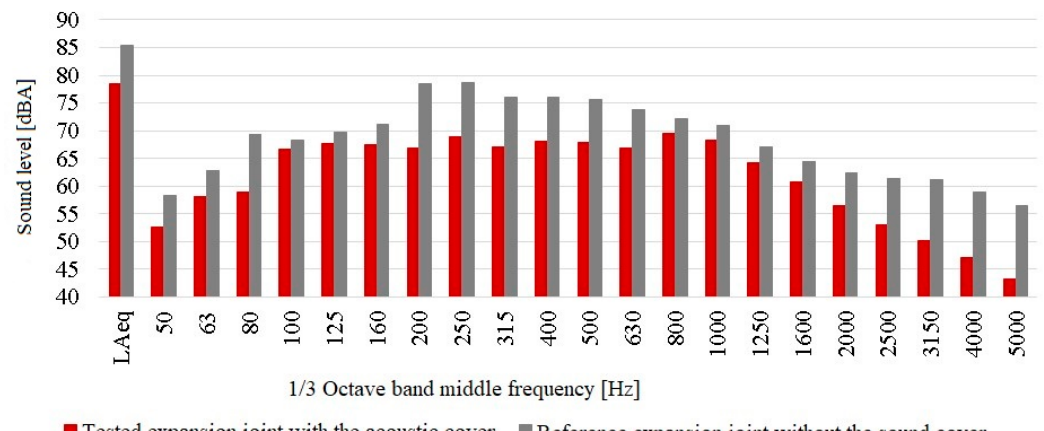
Figure 11. Results of the acoustic measurements at points located under the tested expansion joint equipped with the acoustic cover, and under the reference expansion joint.